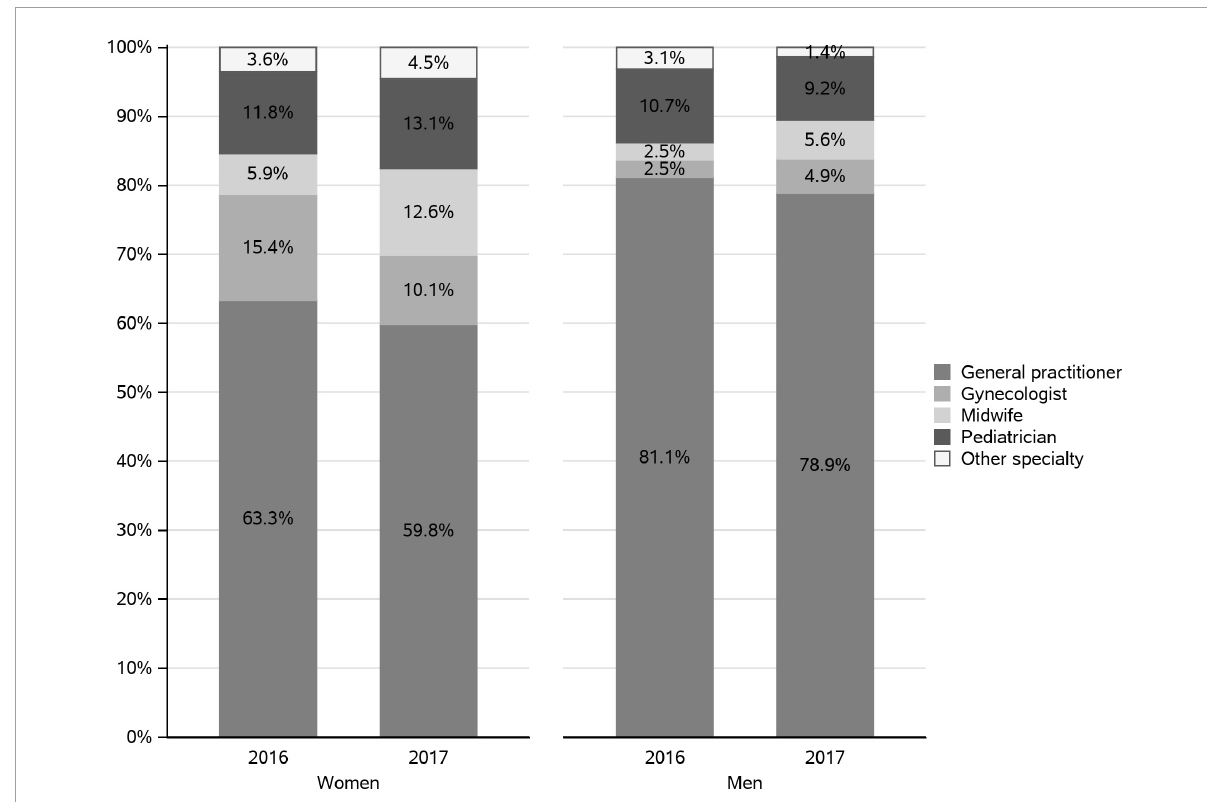
FIGURE5 Specialty of the healthcare professional (HCP) who prescribed the pertussis vaccine in private practice during the “parental project” in 2016 and 2017.